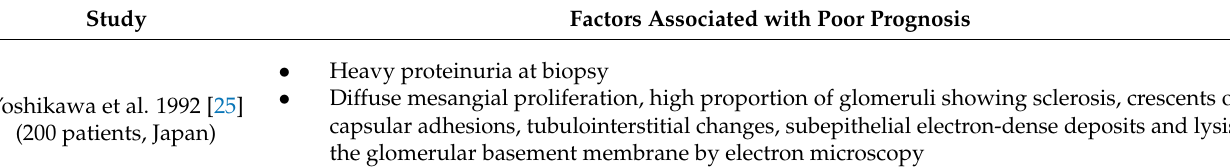
Table 5. Prognostic factors in pediatric